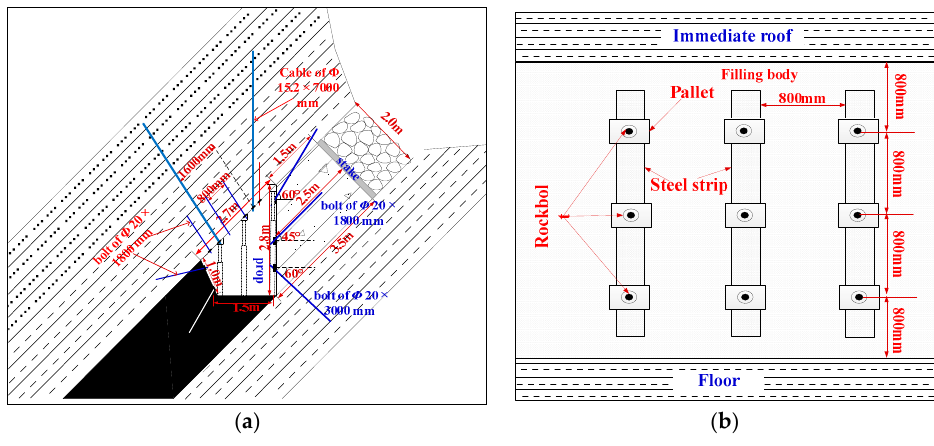
Figure 14. Backfill–truss support structure: ( a ) front view and ( b ) right view.